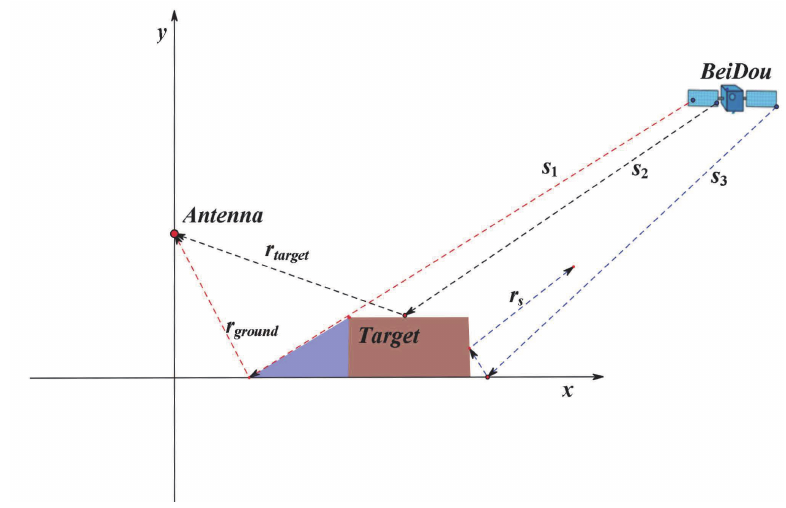
Figure 3. Ground target detection using BeiDou satellite reflected signals. s 1 , s 2 and s 3 are the direct signals from the BeiDou satellite; r target is the satellite signal reflected by the target; and r ground is the signal reflected by the ground. The blue part indicates that the BeiDou satellite signal cannot reach the ground surface covered by the target, and r s represents the signal of the BeiDou satellite after secondary reflection between the ground and the